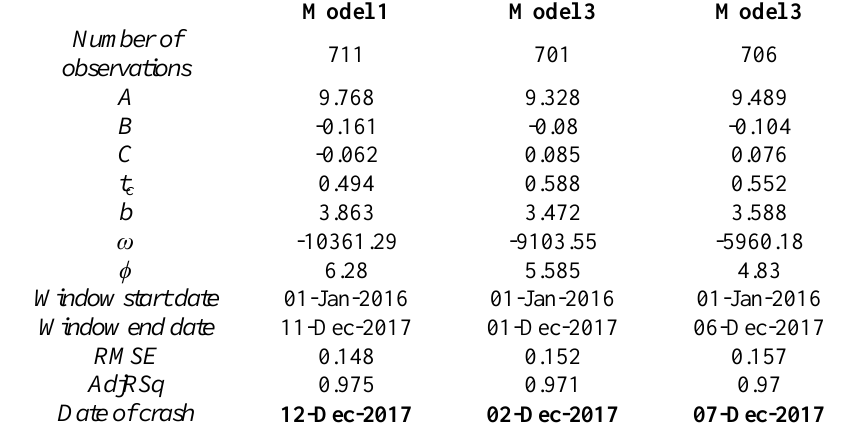
Table 9: The best fit for Bitcoin’s LPPL model